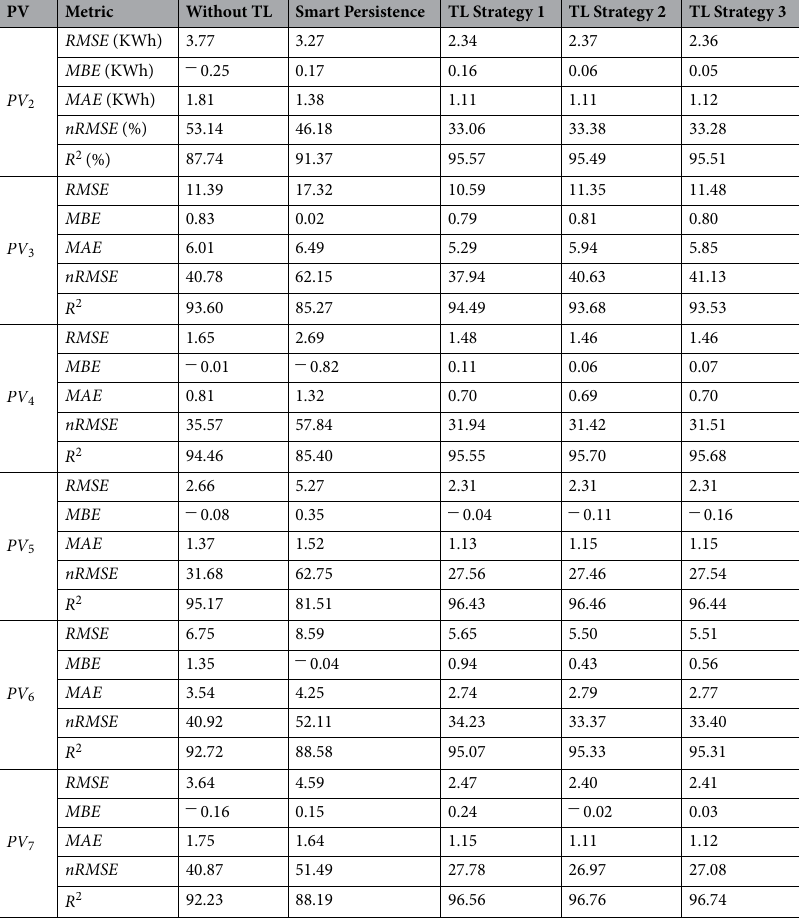
Table 2. Average forecasting performance (accuracy) of the smart persistence model and the stacked LSTM models with and without TL. RMSE , MBE and MAE are measured in KWh, while for R 2 and nRMSE the percentage is given for each